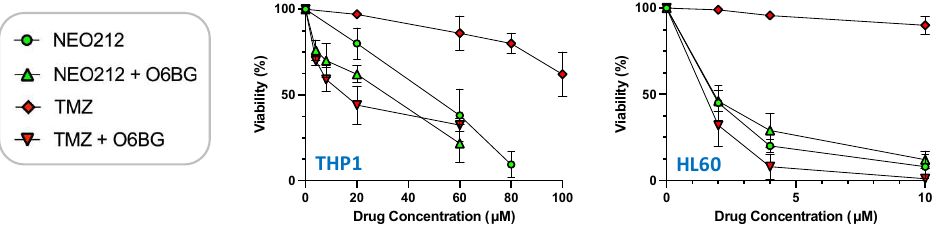
Figure 3. O6BG sensitizes cells to TMZ, but not to NEO212. THP1 and HL60 cells were exposed to increasing concentrations of NEO212 or TMZ in the presence or absence of 30 µM O6BG. After 5 days, cell viability was determined by MTT assay. All values were normalized to vehicle control.